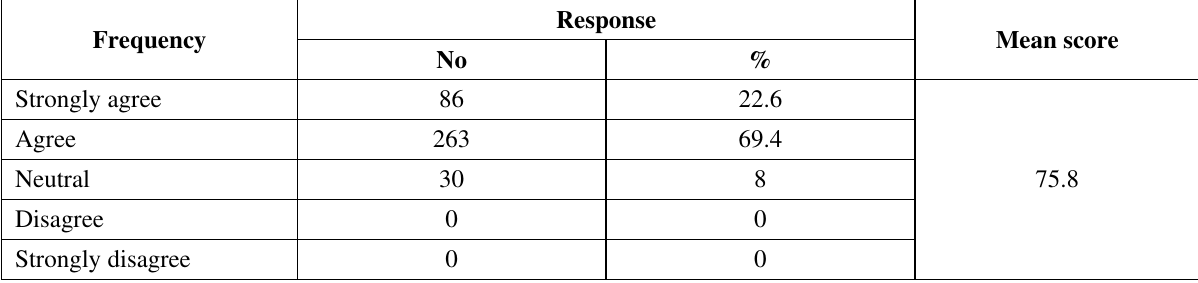
Figure 5. Theoretical proposition 5: socio-economic impact of PPP